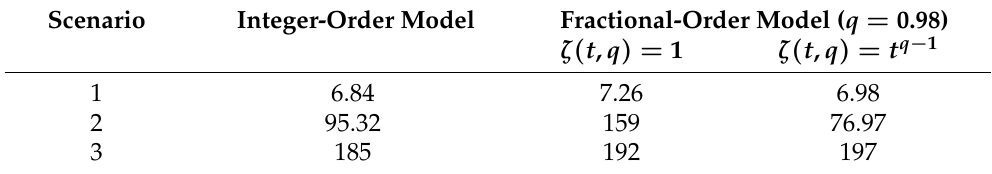
Table 3. Average absolute errors of modeling the data of the Hoosfield spring barley experiment. Scenario